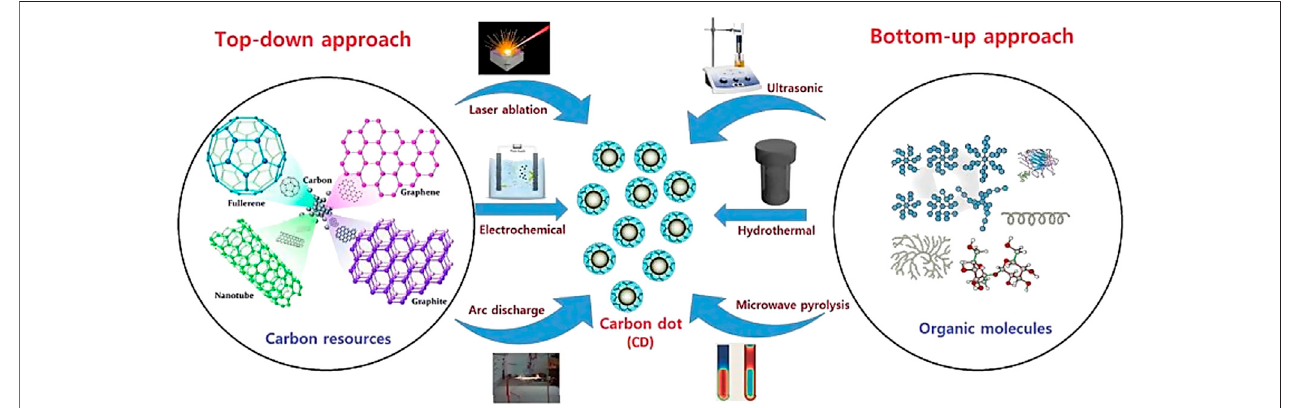
FIGURE 4 | Simple illustration for top-down and bottom-up methods (De and Karak, 2017).